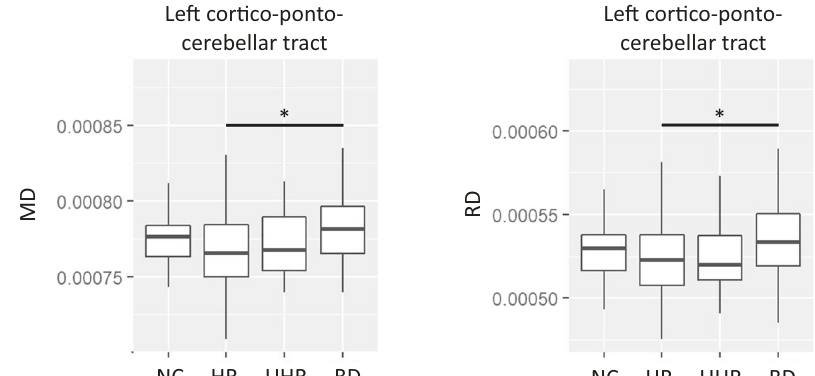
Fig. 2 Diffusivity of left cortico-ponto-cerebellar tract. Left cortico-ponto-cerebellar tract showed signi fi cant group differences in mean diffusivity (MD) and radial diffusivity (RD) between people of different stages of bipolar disorder (BD). Post-hoc comparisons revealed that BD group had signi fi cantly increased MD ( p corrected = 0.043) and RD ( p corrected = 0.039) in the tract when compared with the high-risk (HR) group. NC normal healthy controls, UHR ultra-high risk. * p corrected <